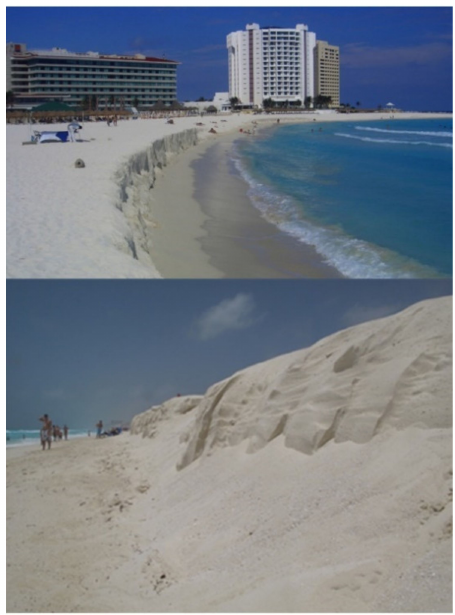
Figure 12. The second beach nourishment was carried out in June 2010. By October 2010 the beach had developed a scarp of almost 2 m height as seen in both photographs.